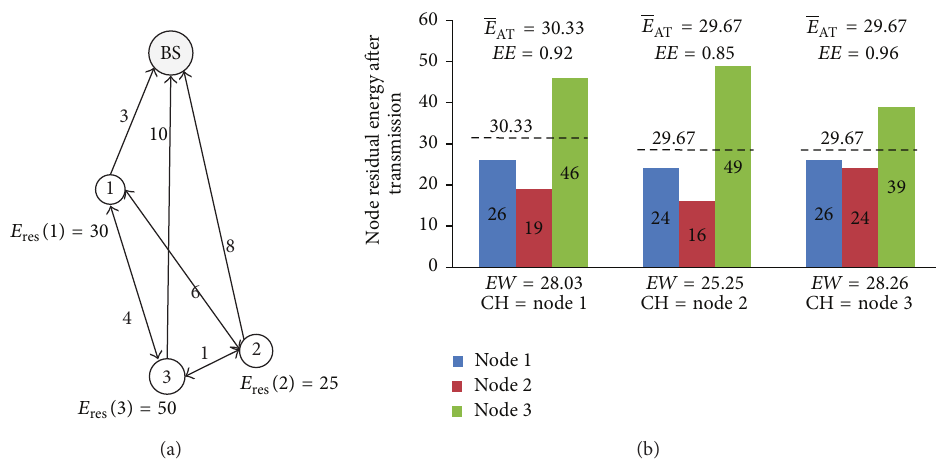
Figure3:Theinstanceoftheenergywelfare.(a)Energyconsumptionrelationshipbetweennodes.(b)Comparisonbetweenremainingenergy of node and clustering